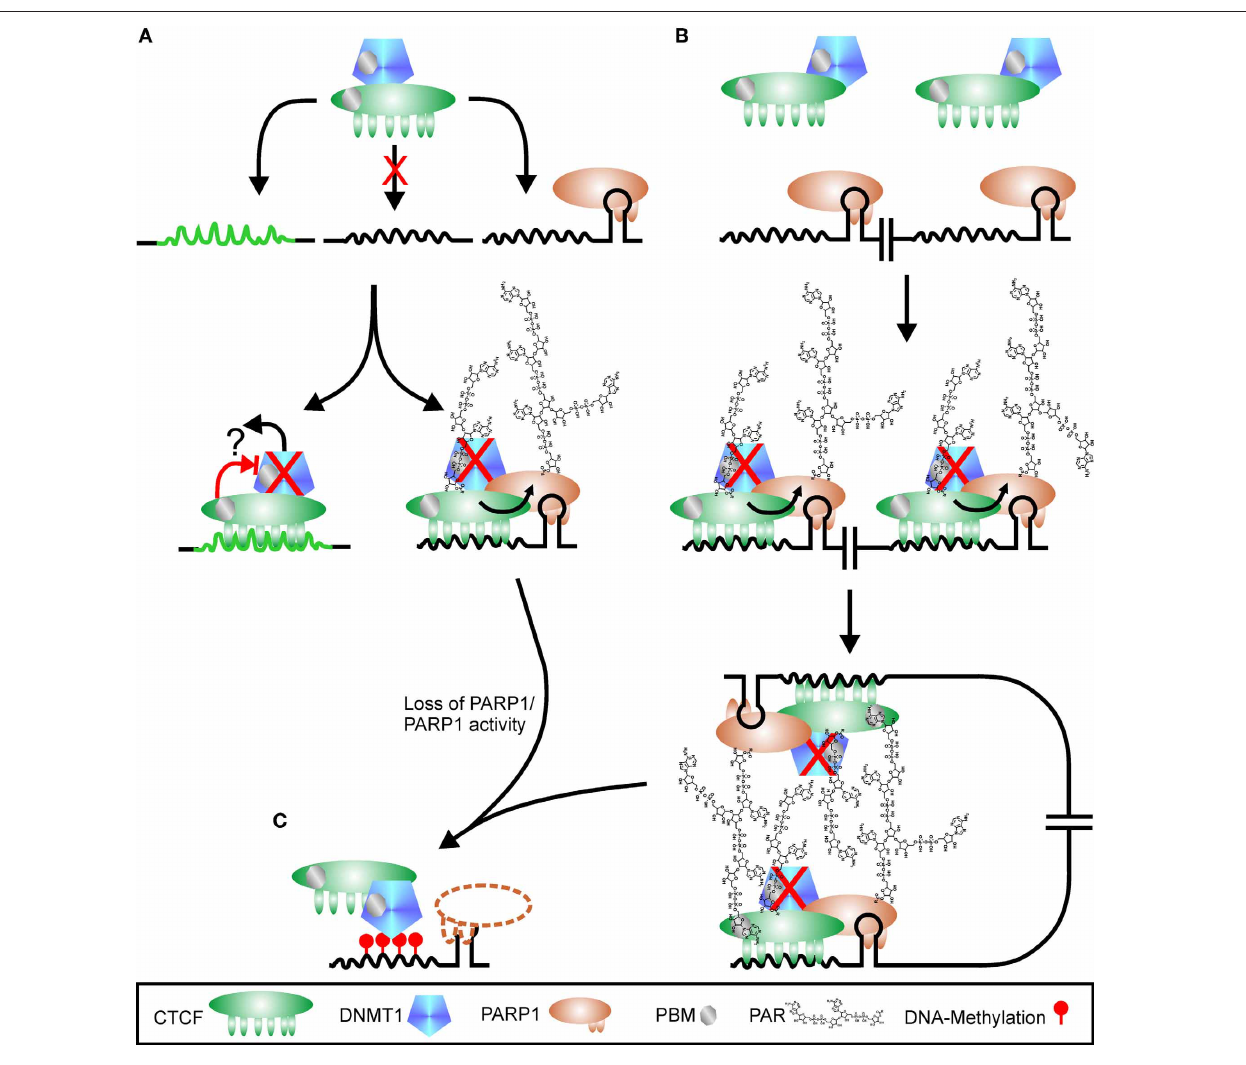
FIGURE 5 | Regulation of CTCF function by PARylation. (A) CTCF shows a high variability in putative binding sequences.Thereare probably high-affinity sites(greenpeakedline)andlow-affinitysites(blackpeakedline),withthelatter one hypothetically only used if additional signals are present, for example PARP1 boundto a stem loop. CTCF is in complexwith DNMT1 (DNA methyl-transferase1). Binding to high-affinity sites may suppress DNMT1 activity directly (red cross), either by altered interaction after DNA-binding (blocked red arrow) or by release of DNMT1 from complex (black arrow and questionmark).InteractionofCTCFwith PARP1onlow-affinitysitesstimulates